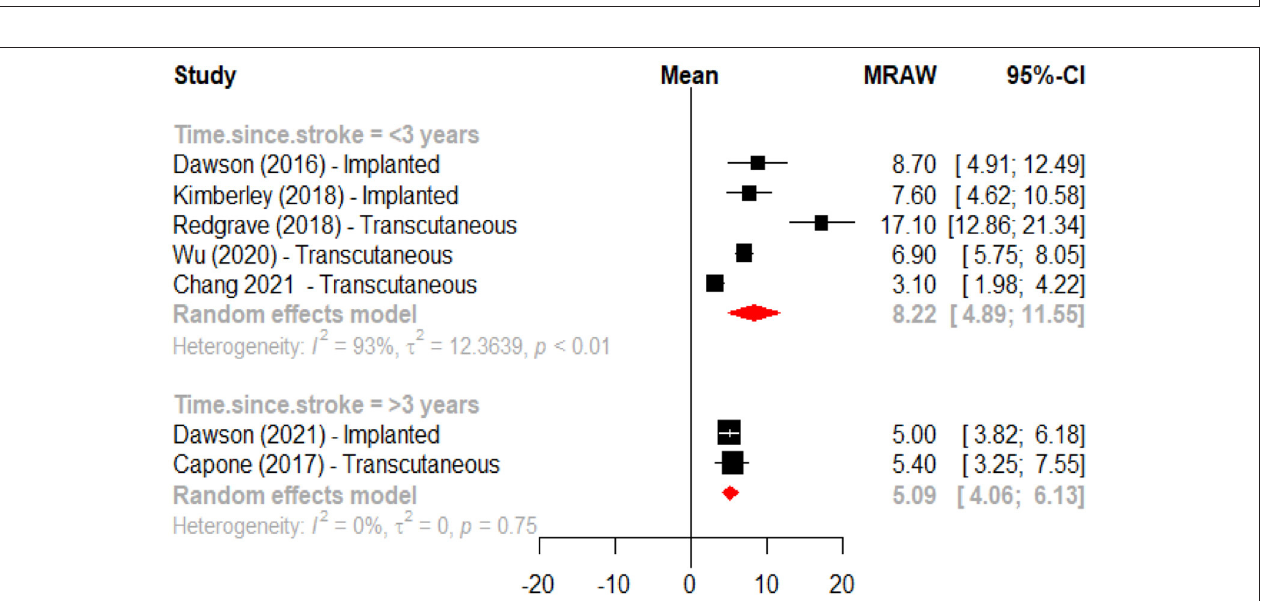
FIGURE 6 | Forest plot for the meta-analysis of vagus nerve stimulation effects on upper limb motor function (FMA-UE score increase) when compared to baseline according to time since stroke ( < 3 years vs. ≥ 3 years).